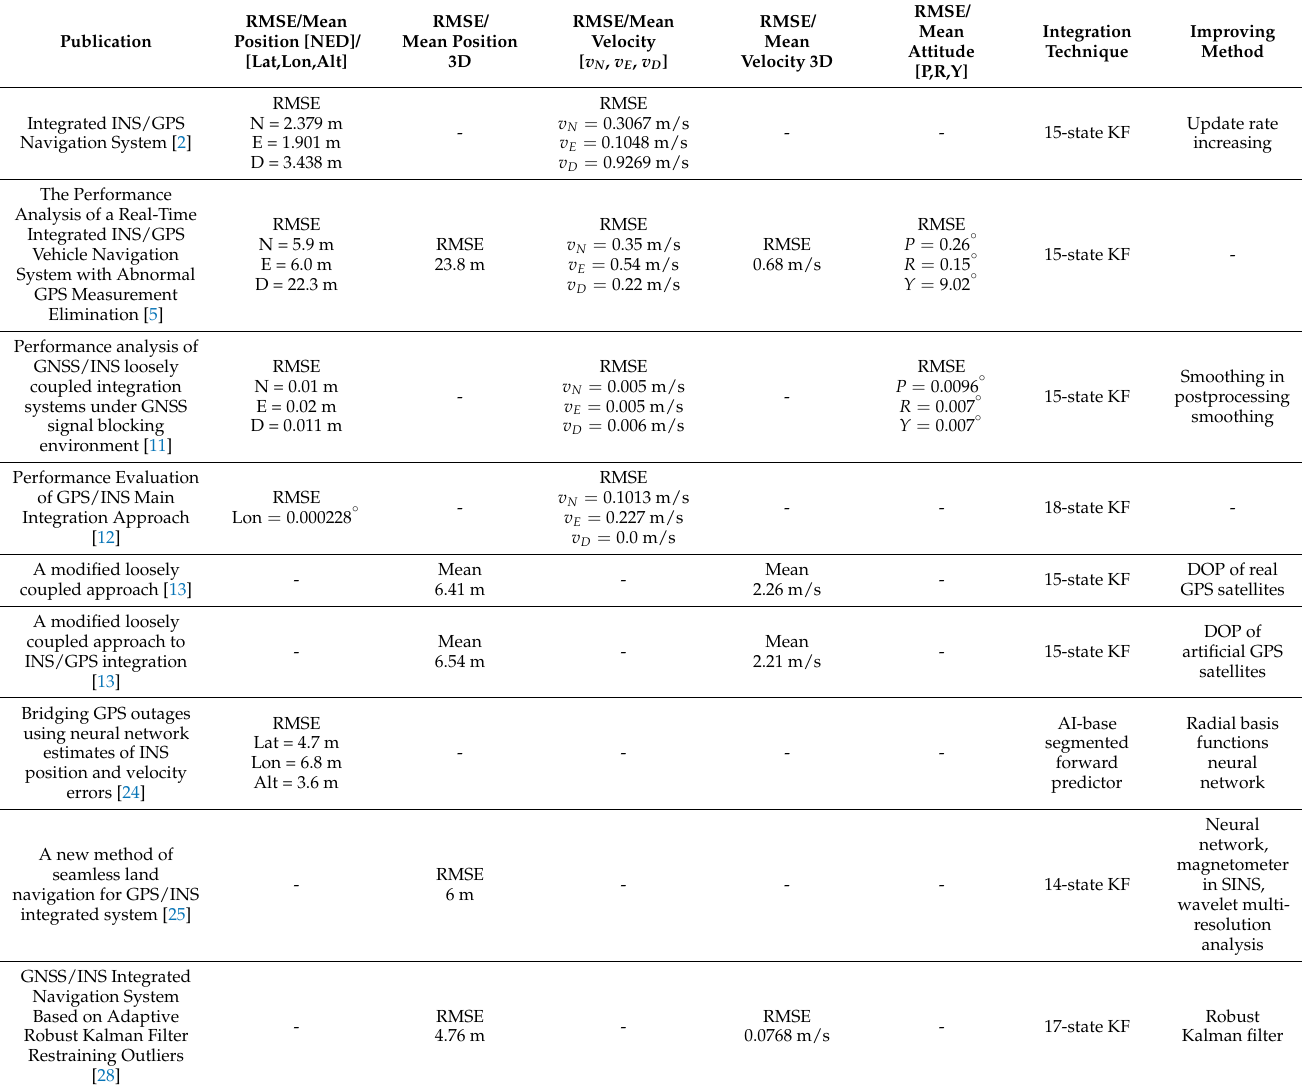
Table 1. Comparative characteristics of loosely coupled integrated GNSS/INS systems in terms of mean error or RMSE and methods used to improve the operation of integrated INS/SNS